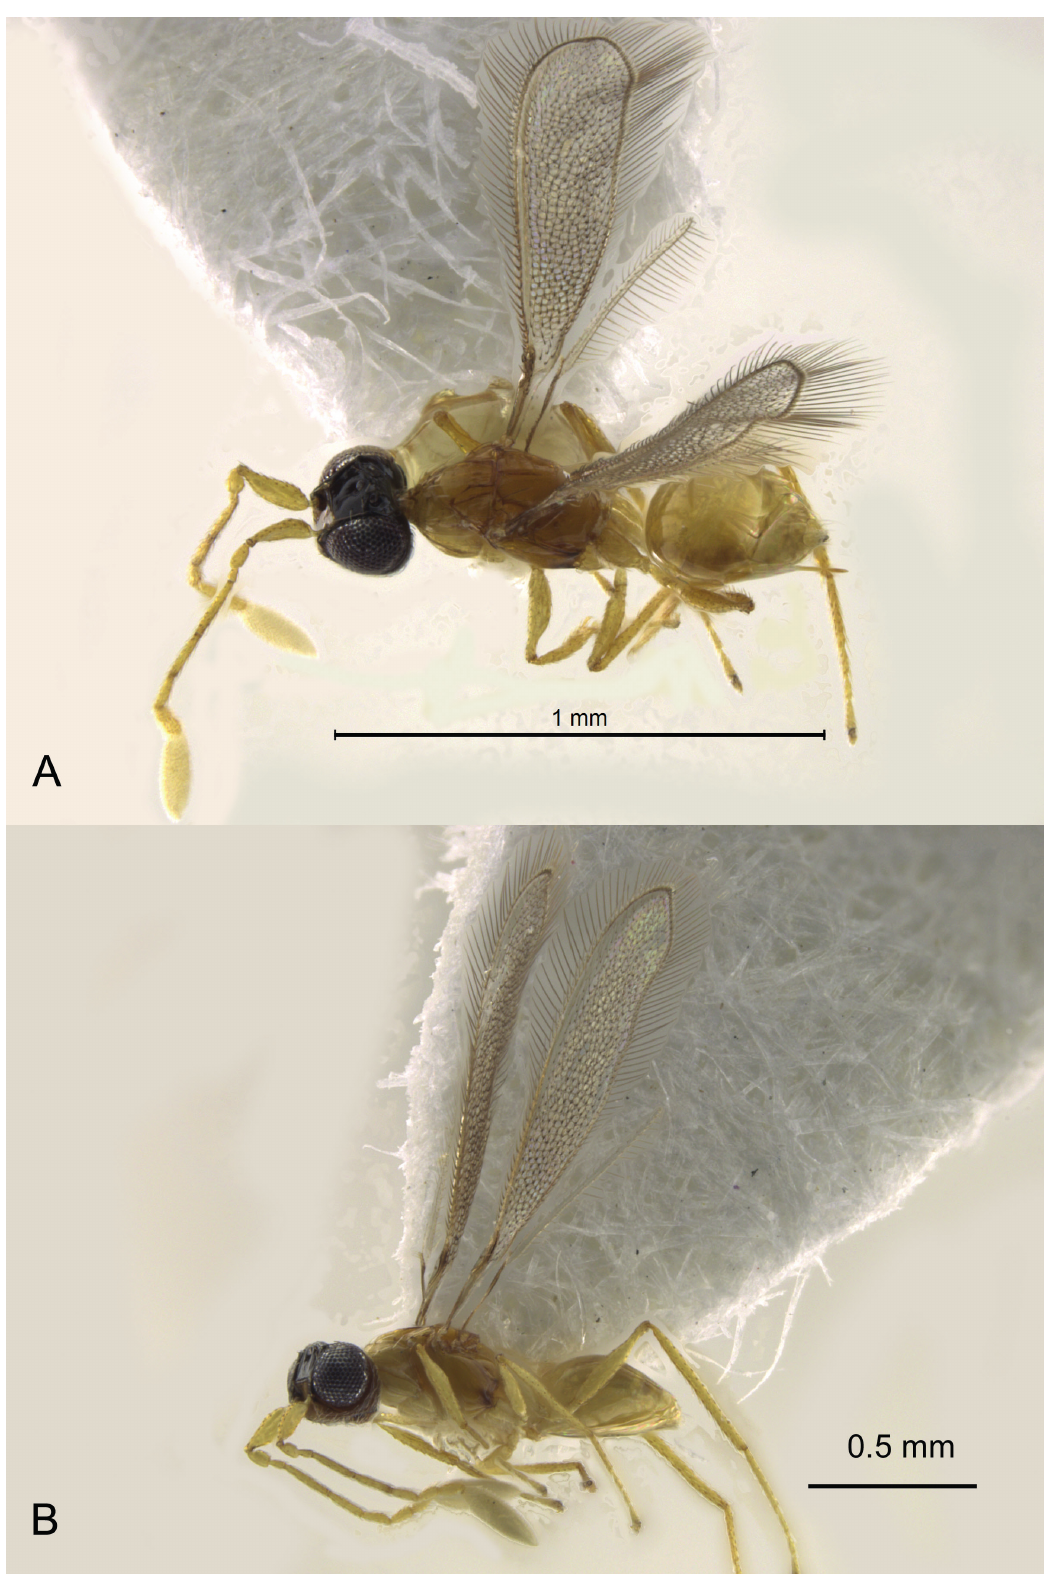
Fig. 1. Ganomymar caslot sp. nov. A . ♀, paratype (CASENT 2079162), habitus in dorsolateral view. B . ♀, paratype (CASENT 2079174), habitus in lateral